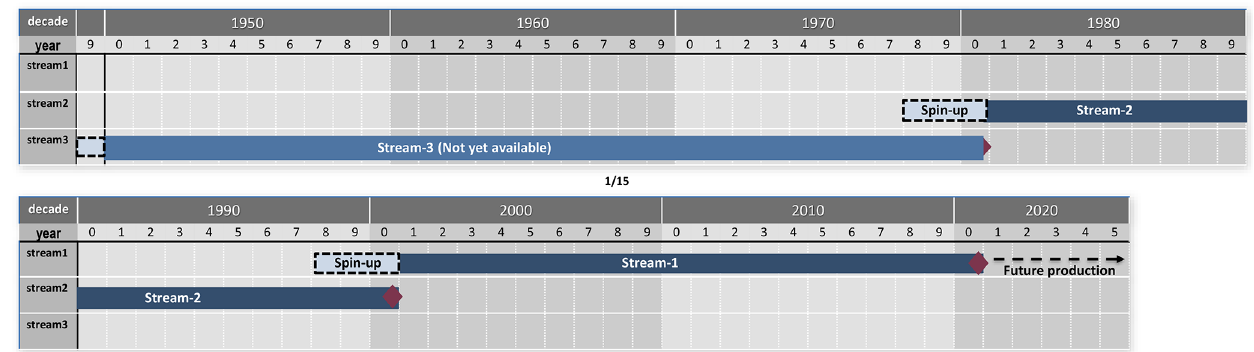
Figure 1. Diagram of the production streams of ERA5-Land. The dark blue lines correspond to the data that have already been produced and are available through the C3S Climate Data Store. The light blue line corresponds to the back-extension period, and at the time of writing this paper is under production. The 3-year spin-up period for stream-1 and stream-2 is presented with dashed rectangles. Stream-3 has a 1-year spin-up (1949). The red diamond presents the end of each stream.